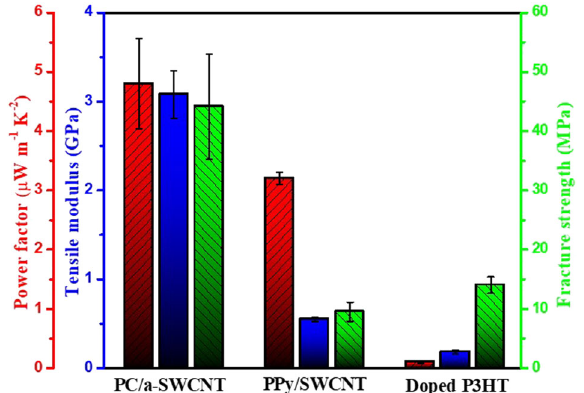
Fig. 4 The comparison of TE and mechanical performances. A comparison of power factors, tensile modulus, fracture strength of PC/a-SWCNT composite in the aligned direction (SWCNT: 10 wt%), PPy/SWCNT composite (SWCNT: 10 wt%) 18 and 2,3,5,6-tetra fl uoro- 7,7,8,8-tetracyanoquinodimethane (F4TCNQ) doped P3HT material 55 . Note that the fracture strength of the doped P3HT material was not